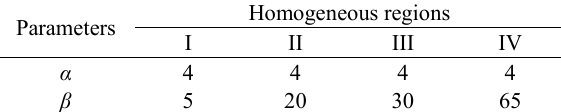
Figure 1. Template and simulated image.